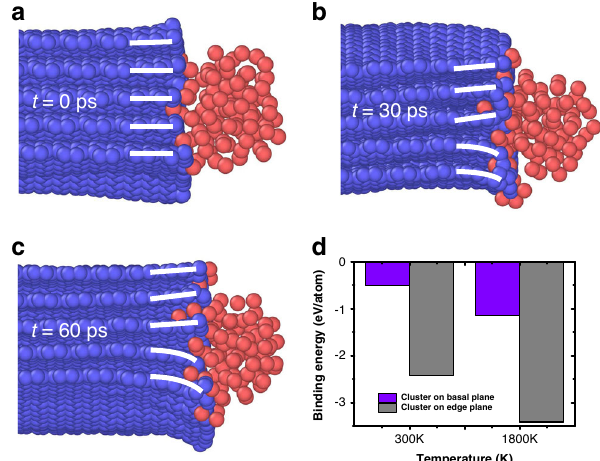
Fig. 6 The morphological derivation of Pt cluster in the presence of T-graphite with edge planes. a – c The morphology of Pt cluster residing in edge planes with the temperature 1800 K, after different time relaxations. d The dependence of binding energy of cluster with different locations and various